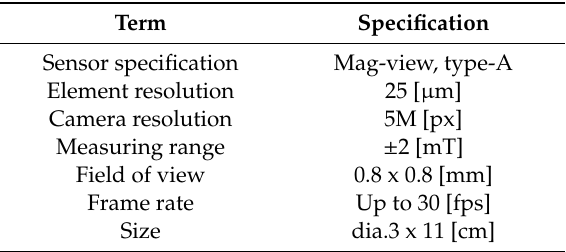
Table 1. Specifications of Magneto-Optical sensor used in this experiment. It has enough resolution to read the information of the tag.